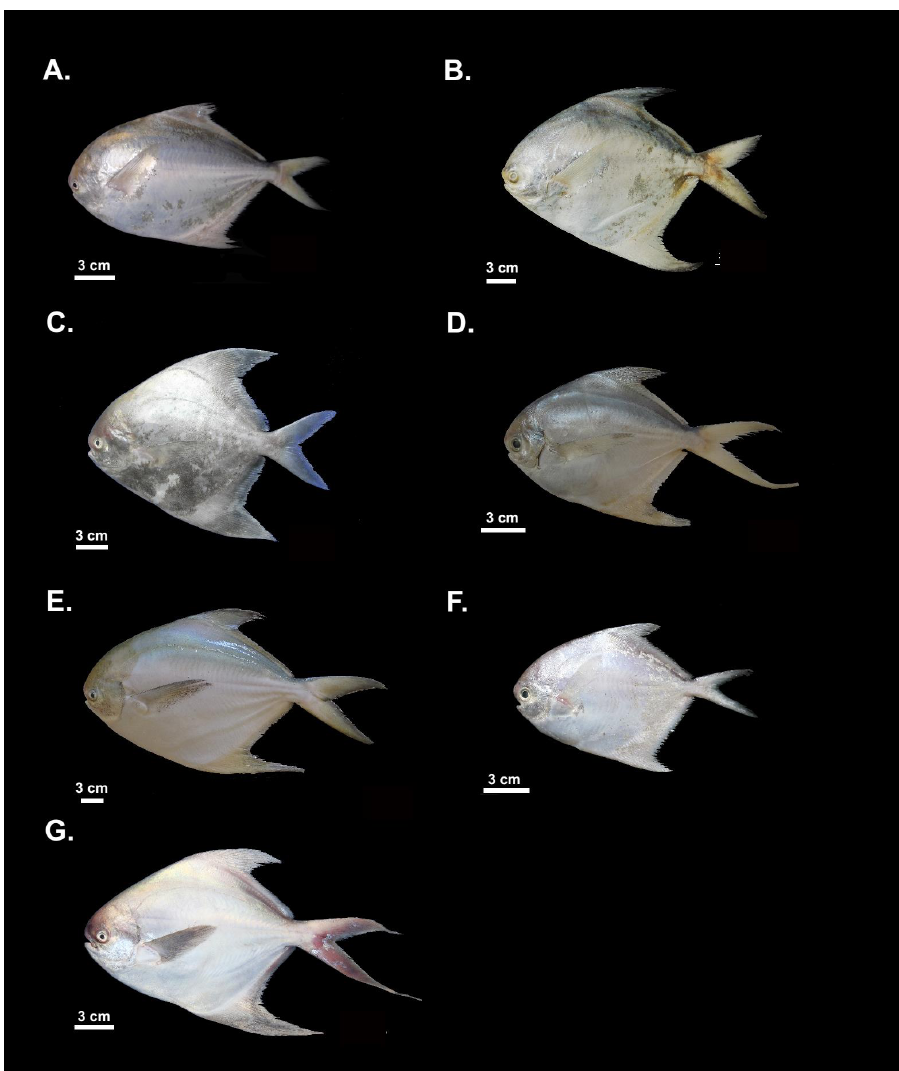
Figure 1. Photographs of the seven studied Pampus species of this study. ( A ) P. argenteus (PA-IOCAS120435); ( B ) P. candidus (PCA-2015004); ( C ) P. chinensis (PCH-201006003); ( D ) P. cinereus (PCI-20120520); ( E ) P. liuorum (PL-IOCAS120542); ( F ) P. minor (PM-2012504); ( G ) P. punctatissimus (PP-2013129).